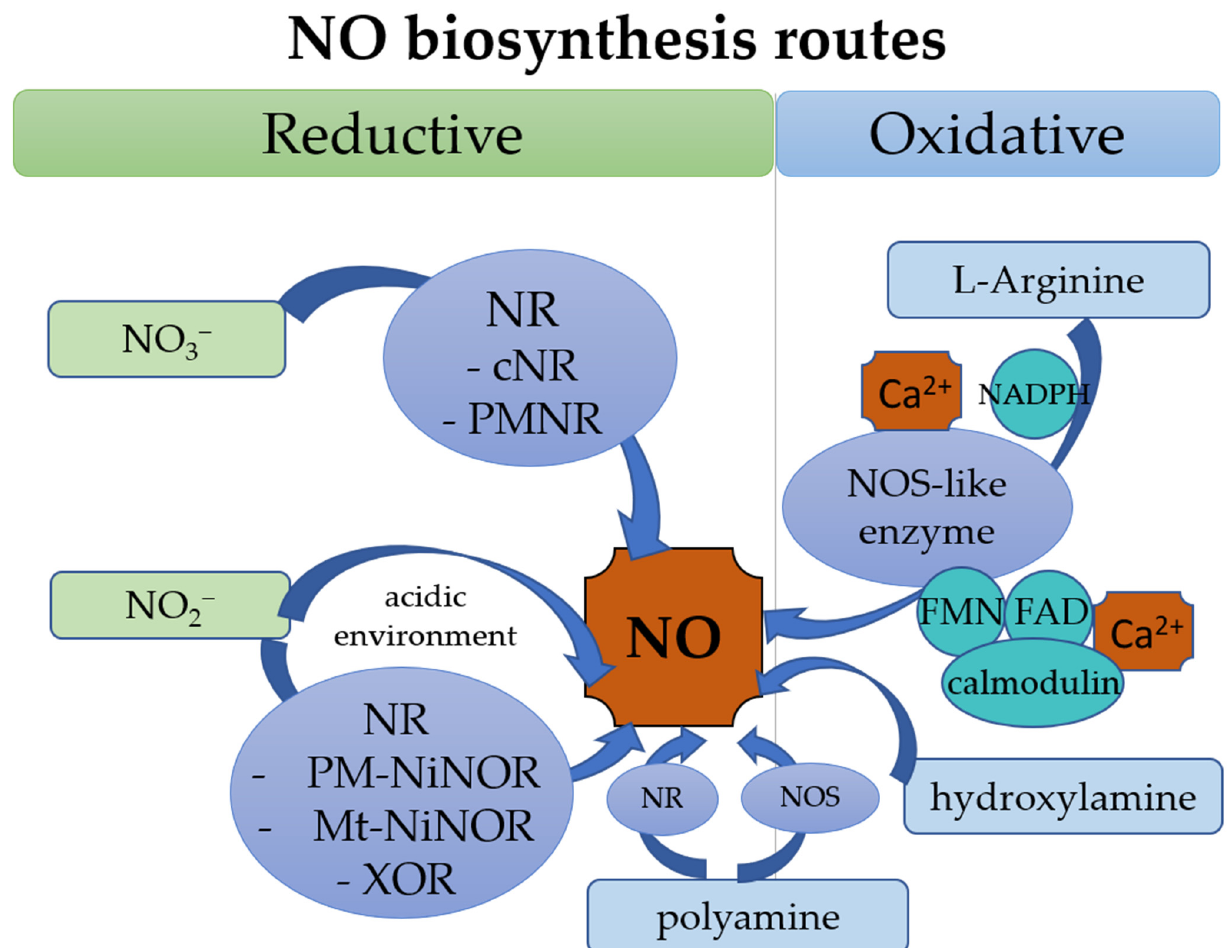
Figure 1. Schematic diagram showing the major routes of nitric oxide (NO) biosynthesis. NO synthesis occurs through (I) reductive mechanism or (II) oxidative mechanism. (I) NO reductive mechanism mostly occurs in plasma membrane, chloroplasts, apoplast, peroxisomes, cytoplasm, and mitochondria through reduction of nitrate (NO 3 − ) or nitrite (NO 2 − ) by nitrate reductase (NR). NO production through nitrate substrate is reduced by cytosolic nitrate reductase (cNR) and by plasma membrane-bound nitrate reductase (PMNR), whereas NO production through nitrite substrate is reduced by plasma membrane-bound nitrite: NO reductase (PM-NiNOR), mitochondrial electron transfer chain-dependent enzymatic nitrite: NO reductase (Mt-NiNOR), XOR. In an acidic environment, nitrite produces NO through several reversible reactions. Polyamines induce NO production through reductive and oxidative mechanisms. (II) The oxidation of L-Arg takes place in chloroplasts and leaf peroxisomes. In chloroplasts, the oxidation of L-Arg requires nicotinamide adenine dinucleotide phosphate (NADPH) and calcium ions (Ca 2+ ), whereas in leaf peroxisomes, the oxidation of L-Arg requires flavin mononucleotide (FMN), flavin adenine dinucleotide (FAD), calmodulin, and Ca 2+ . Hydroxylamine acts as a substrate in the oxidative mechanism; however, its pathway in NO production remains unclear. NOS, NO synthase.